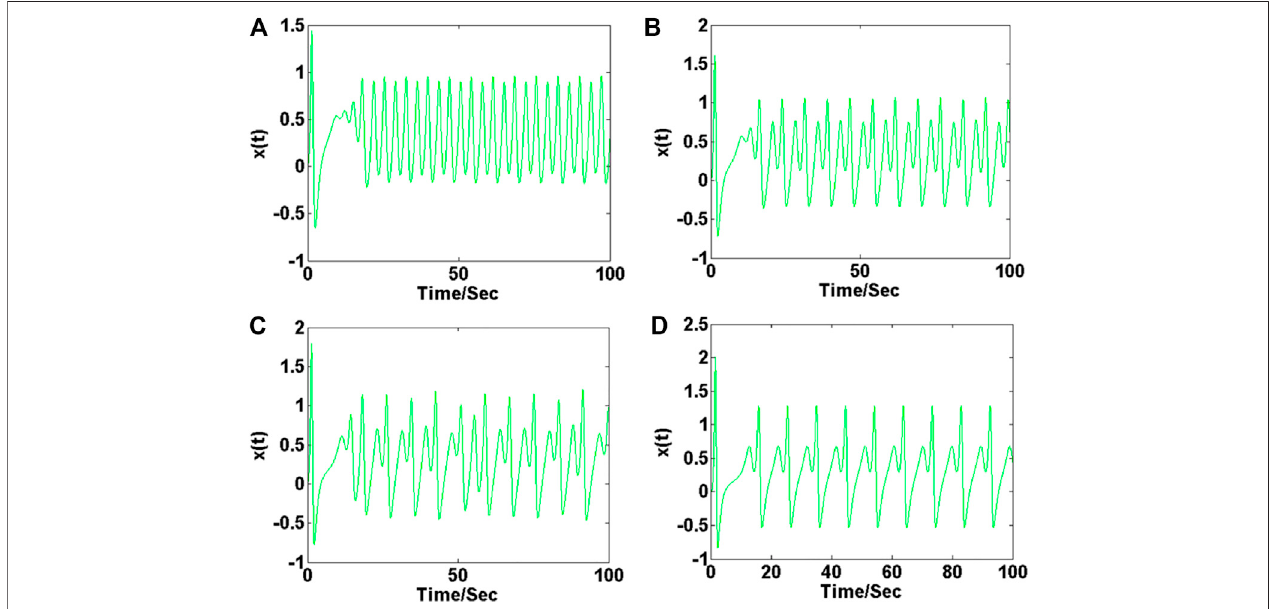
FIGURE9| Timeseriesofmembranepotentialunderdifferentparameters a ofsystem(10)with b (cid:1) 5.5, c (cid:1) 1.7, d (cid:1) 2.5andinitialcondition(0,0,0): (A) a (cid:1) 2.2, (B) a (cid:1) 2.5, (C) a (cid:1) 2.8, (D) a (cid:1) 3.